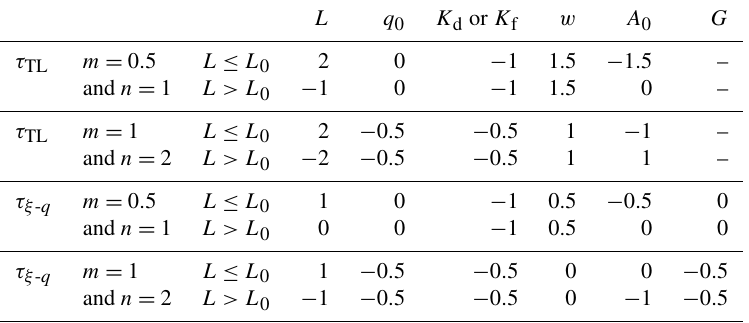
Table B1. Scaling of the TL and ξ – q response times, τ TL and τ ξ – q , with the various parameters for two sets of values of m and n . I consider a linear case ( n = 1) and a nonlinear case ( n = 2) but keep the ratio between m and n at 0.5. For both cases, I use p =